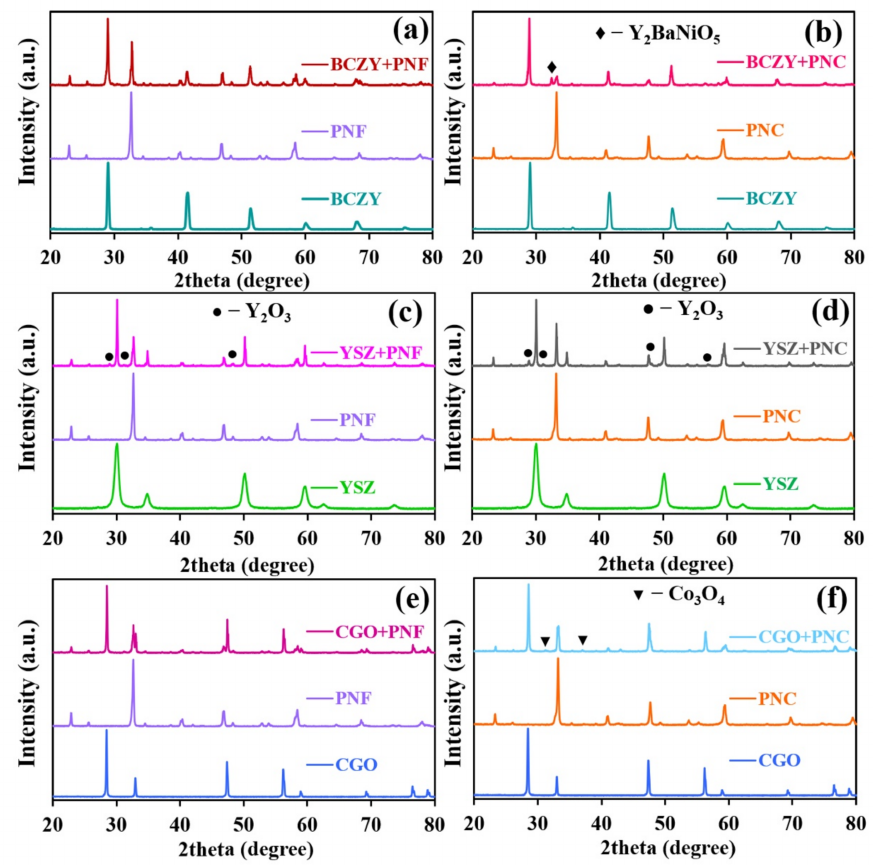
Figure 2. XRD patterns of the PrNi 0.4 Fe 0.6 O 3– δ ( a , c , e ) or PrNi 0.4 Co 0.6 O 3– δ ( b , d , f ) with BCZY ( a , b ), YSZ ( c , d ), and CGO ( e , f ) powders after treatment at 1100 ◦ C for 10